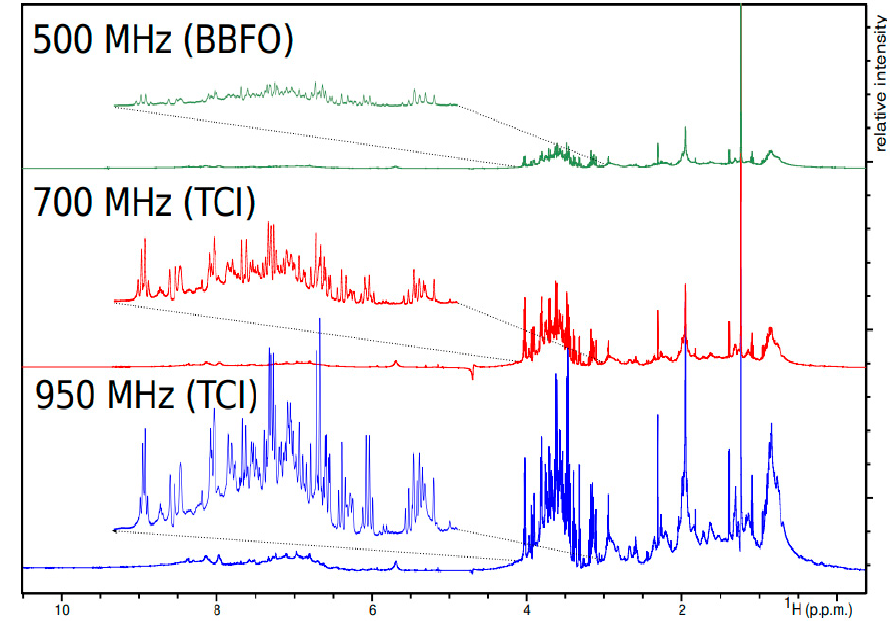
Figure 4. Demonstration of magnetic field strength and probe specificity on spectral resolution of bovine serum recorded with the same parameter set on three spectrometers working at 500, 700, and 950 MHz proton frequencies at 25 °C. The probes used are the Bruker TCI—Triple Resonance CryoProbe on the 700 MHz and 950 MHz instruments and a Bruker BBFO on a 500 MHz magnet.